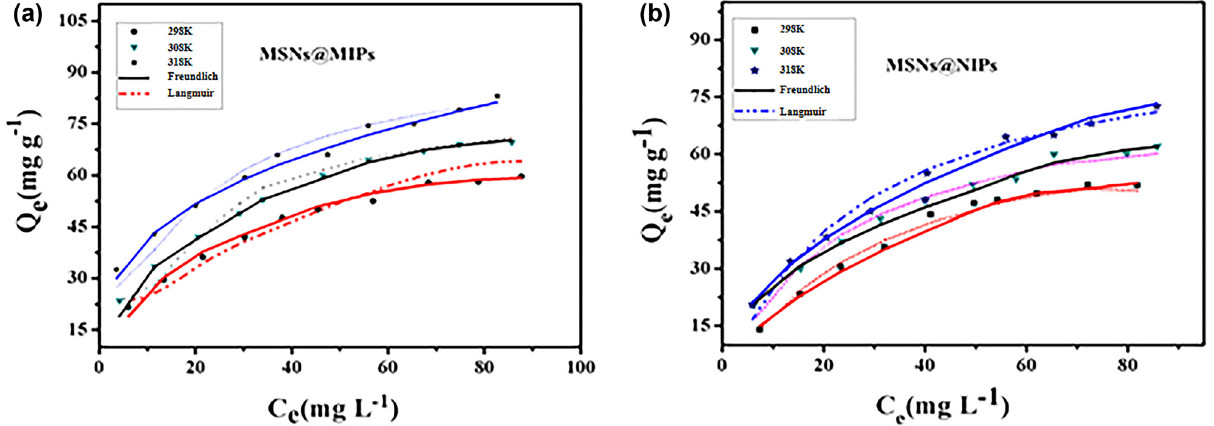
Figure 7: Langmuir and Freundlich isotherms fi t curves of ( a ) MSNs@MIPs and ( b )